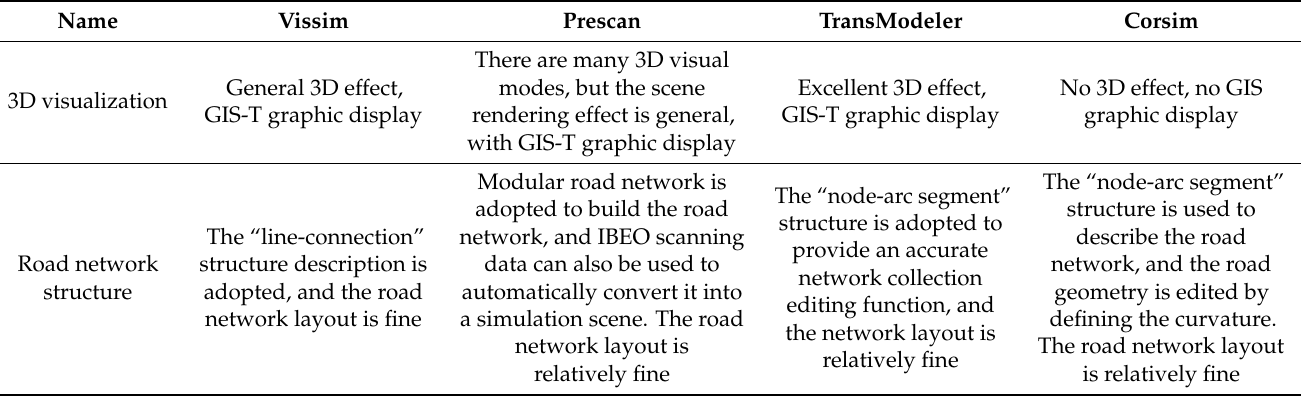
Table 5. Comparison of road network construction with different software.